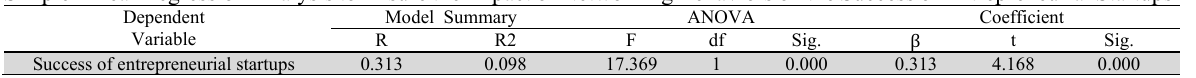
Simple Linear Regression Analysis to Ensure the Impact of Networking Behaviors on the Success of Entrepreneurial Startups Dependent